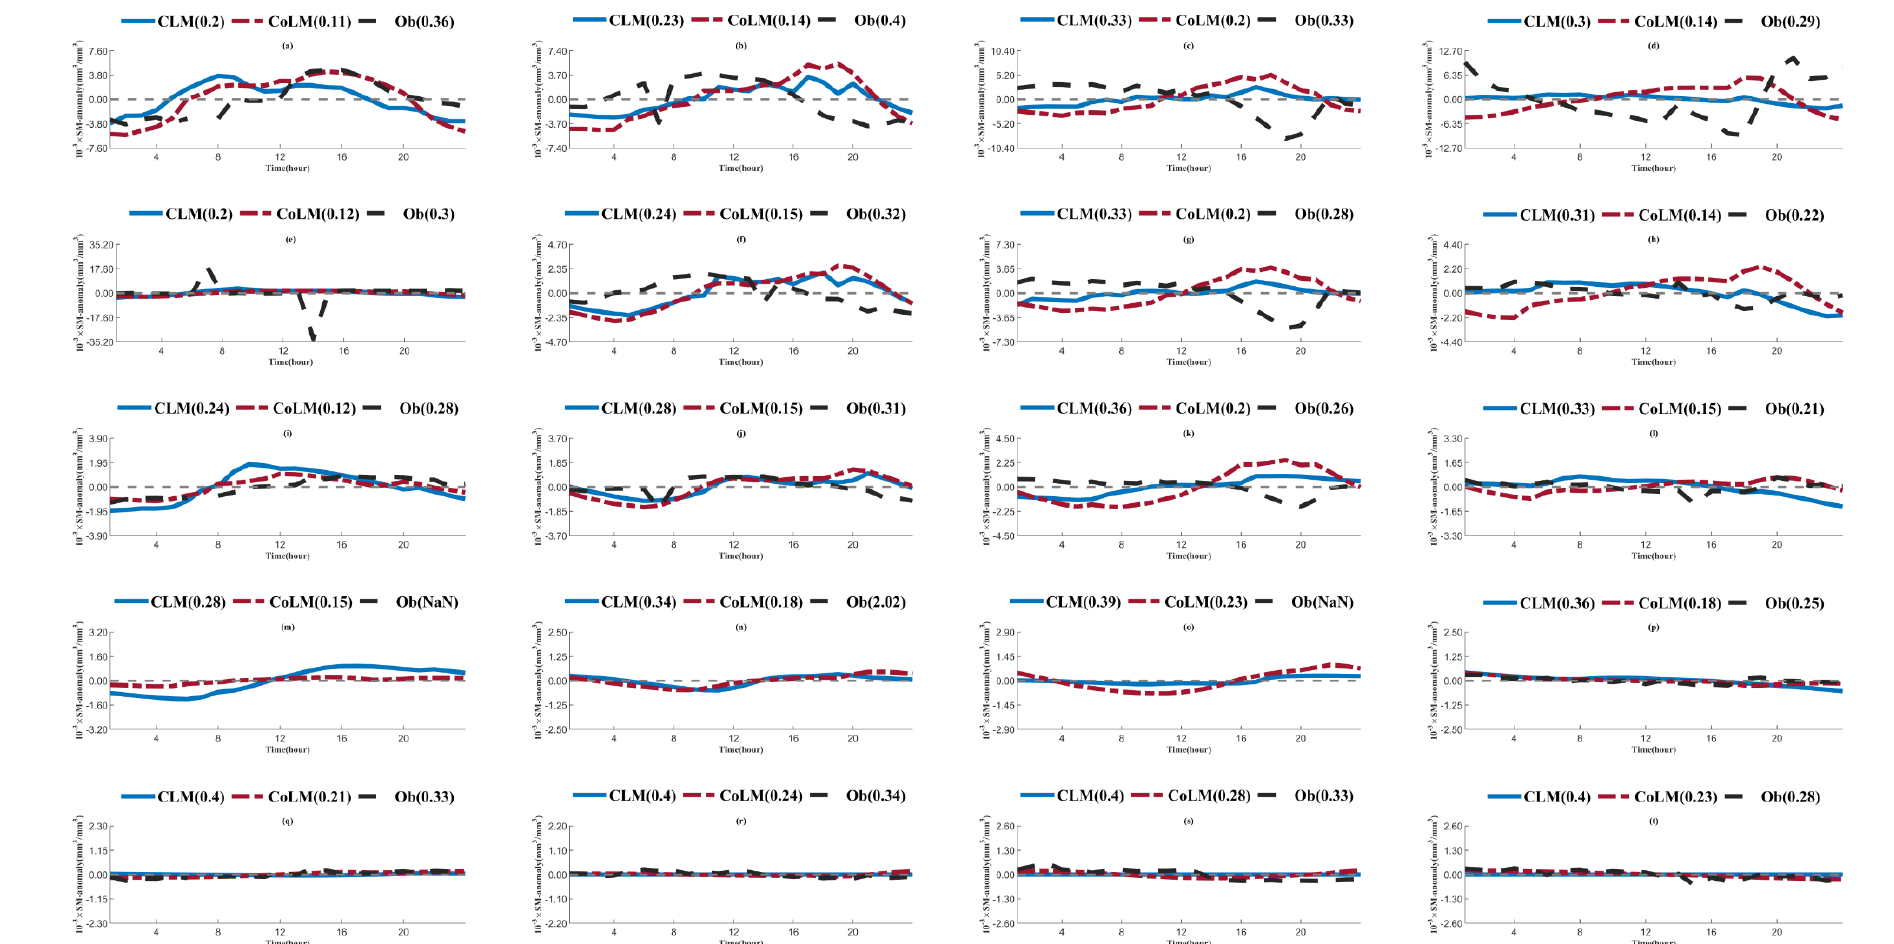
Figure 9. Anomalies in diurnal soil moisture variations in four seasons at Tnc Fort Bayou site, with CLM5 in blue, CoLM2014 in red, and observation in black. The seasonal mean values of soil moisture are in brackets. ( a , e , i , m , q ) Soil moisture anomalies in winter in layers 1 to 5, respectively. ( b , f , j , n , r ) Soil moisture anomalies in spring in layers 1 to 5, respectively. ( c , g , k , o , s ) Soil moisture anomalies in summer in layers 1 to 5, respectively. ( d , h , l , p , t ) Soil moisture anomalies in autumn in layers 1 to 5, respectively.